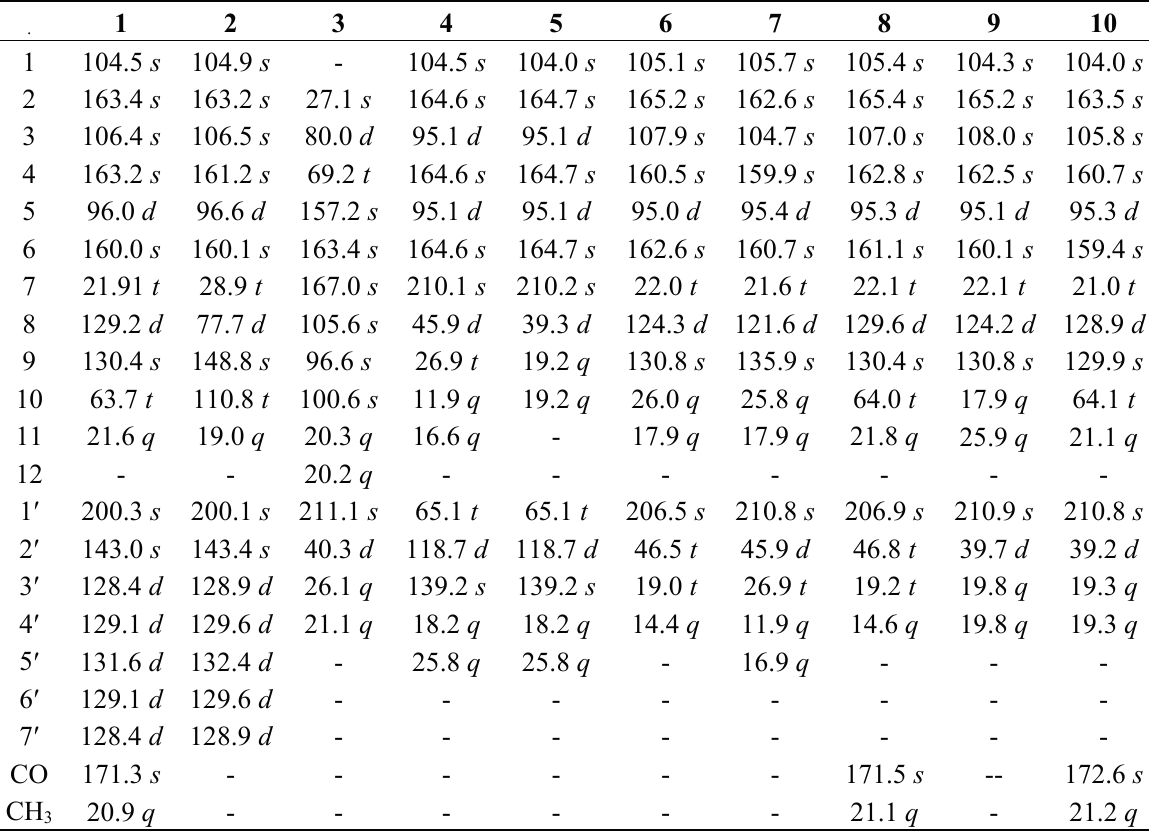
Table 2. 13 C-NMR spectral data of compounds 1 – 10 in CDCl 3 ( 4 , 5 , 7 and 10 ) or CD 3 COCD 3 ( 1 – 3 , 6 , 8 , 9